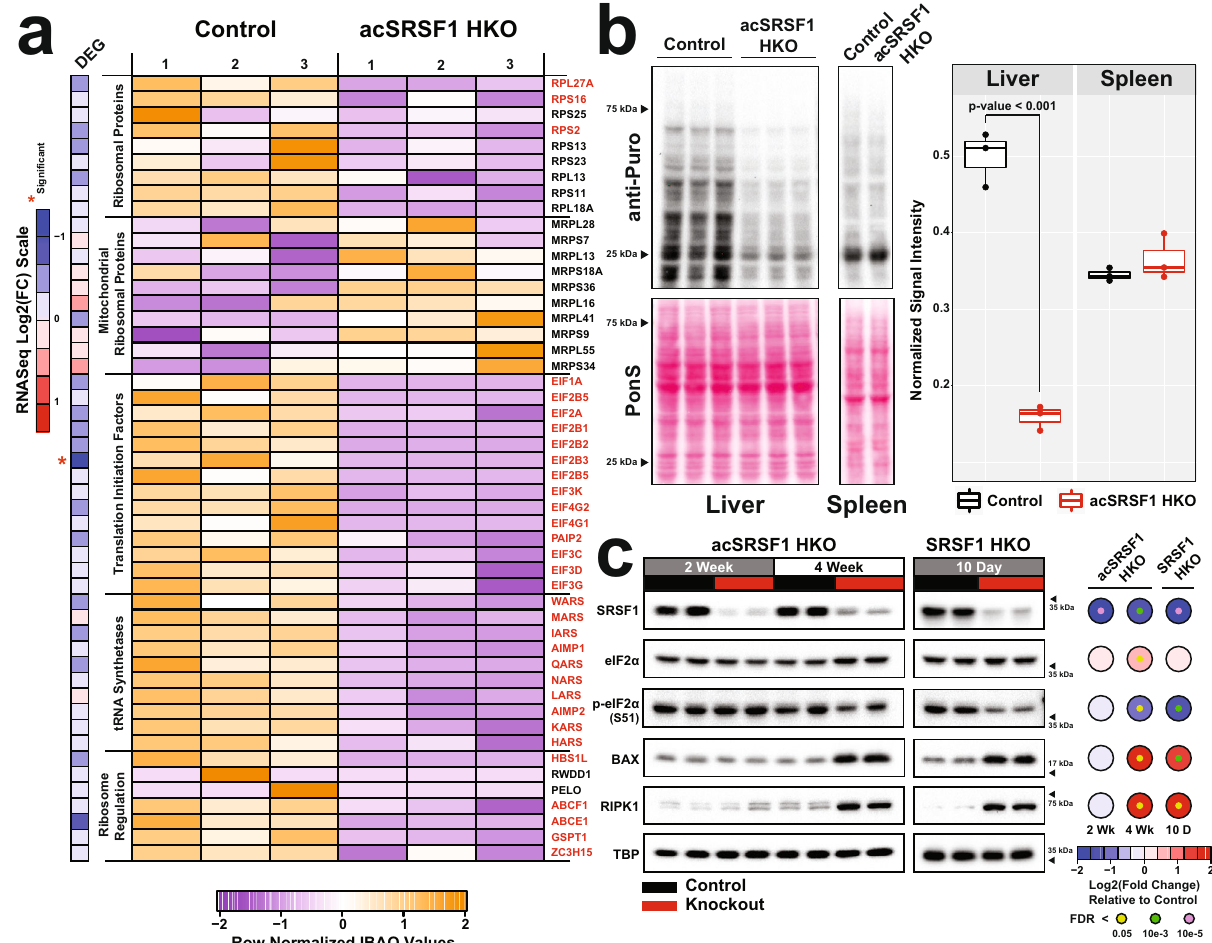
Fig. 8 | Acute SRSF1 HKO hepatocytes display striking defects in global trans- lation.a HeatmapdepictingrelativeproteinabundancesbasedoncalculatedIBAQ values (row normalized) of various factors involved in translation from mass spectrometry of control and acSRSF1 HKO hepatocytes ( n =3 biologically inde- pendent animals per group). The factor labeled in red indicates a signi fi cant dif- ference in abundance (Log 2 |Fold Change| ≥ 1, FDR<0.05) between control and knockouts. The heatmap strip on the left shows the relative fold change in mRNA abundance of the associated factor. b Measurement of de novo protein synthesis using a puromycin incorporation assay on hepatocytes isolated from control and acSRSF1 HKO at the 2-week timepoint ( n =3 biologically independent animals per